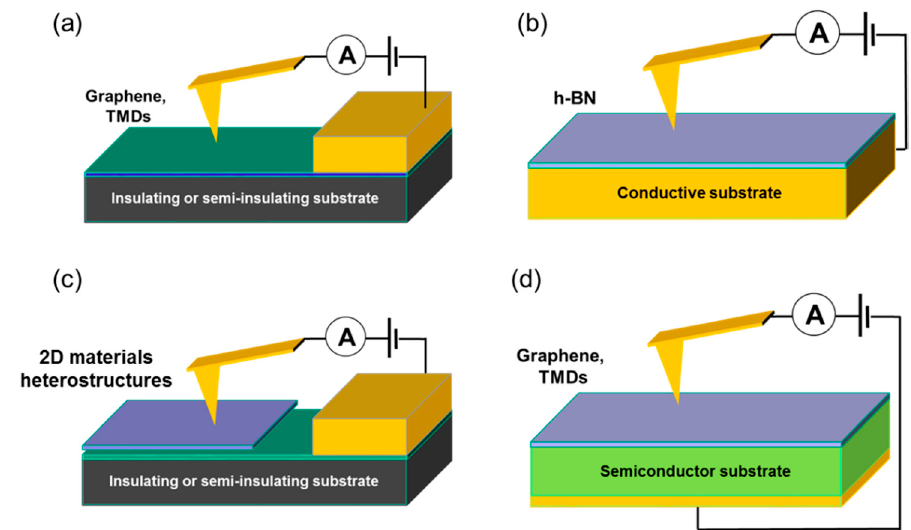
Figure 1. Schematic illustration of conductive atomic force microscopy (C-AFM) applications in two dimensional (2D) materials characterizations. ( a ) Lateral current transport in semi-metallic graphene or semiconducting TMDs. ( b ) Tunneling current through insulating hexagonal boron nitride (h-BN). ( c ) Current transport in 2D materials vertical (or lateral) heterostructures. ( d ) Current injection in the heterojunctions of 2D materials (graphene or TMDs) with bulk semiconductors.